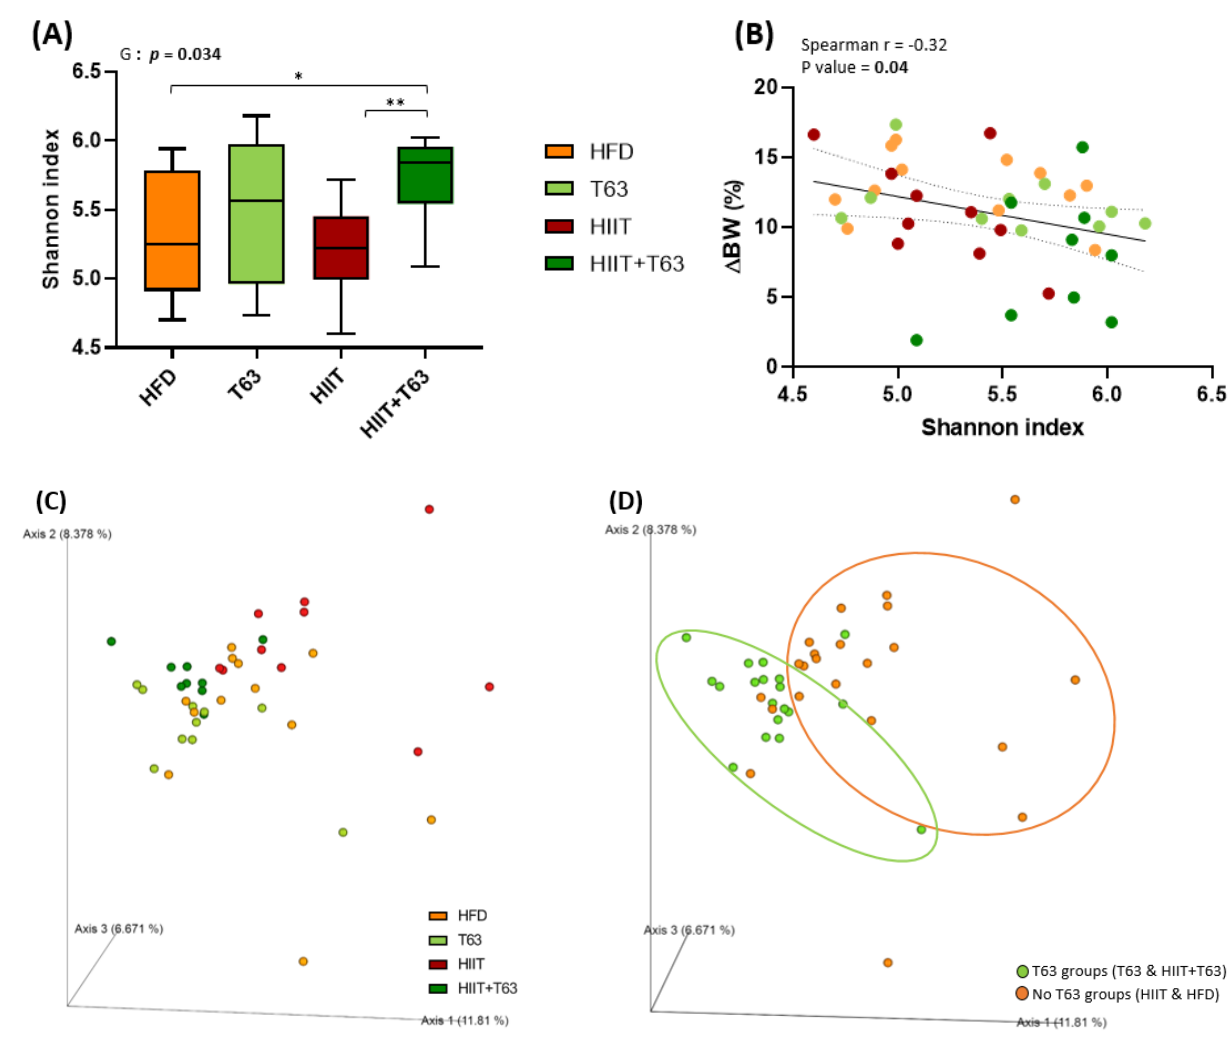
Figure 7. Mucosa-associated microbiota composition analyzed by 16S rRNA gene sequencing in colon DNA samples (Illumina MiSeq system). Shannon index ( A ), correlation between Shannon index and body weight change (%) ( ∆ BW) ( B ). Unweighted Unifrac analysis clustered in four groups ( C ) and two groups (T63 and no T63) ( D ), G: group effect. * p < 0.05, ** p <